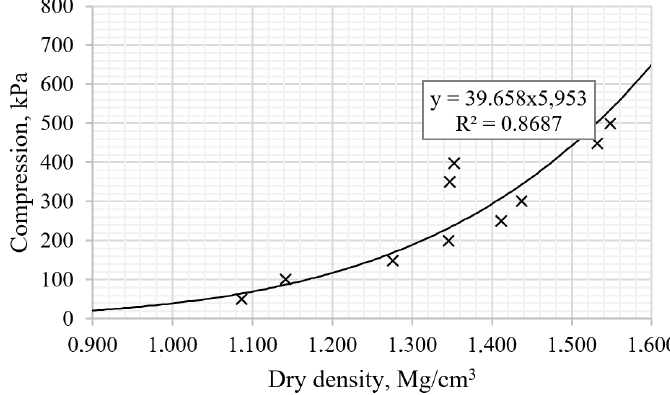
Figure 5. Clay consolidation test results.